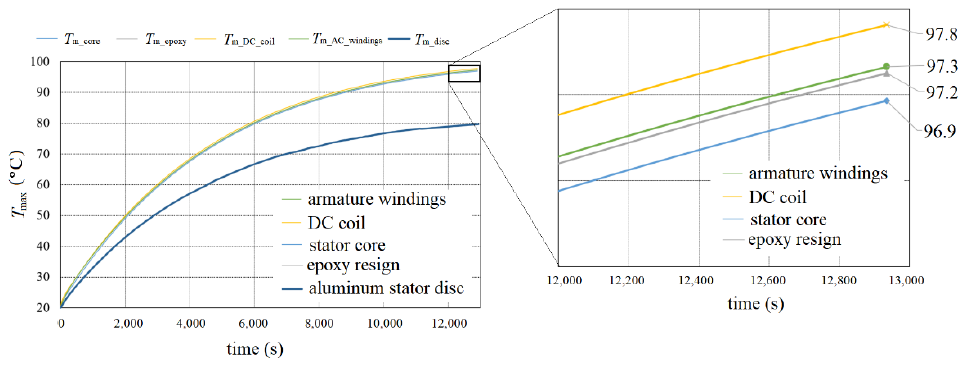
Figure 13. Heat Figure 13. Heat characteristics.